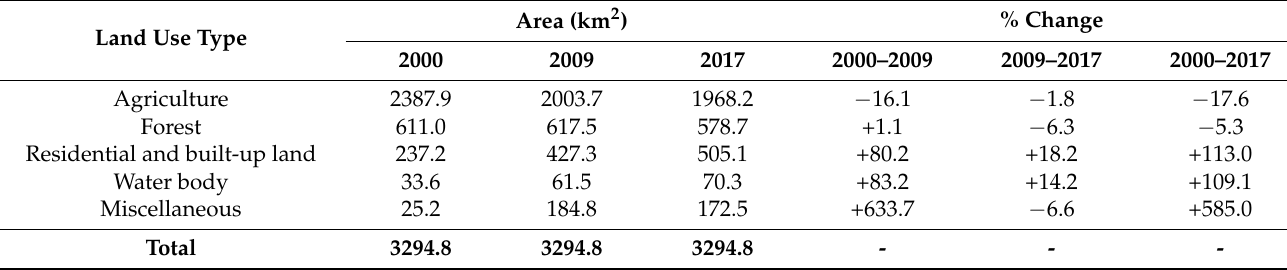
Table 1. Change in the spatial extent of land use in the Lam Takong River Basin during 2000, 2009, and